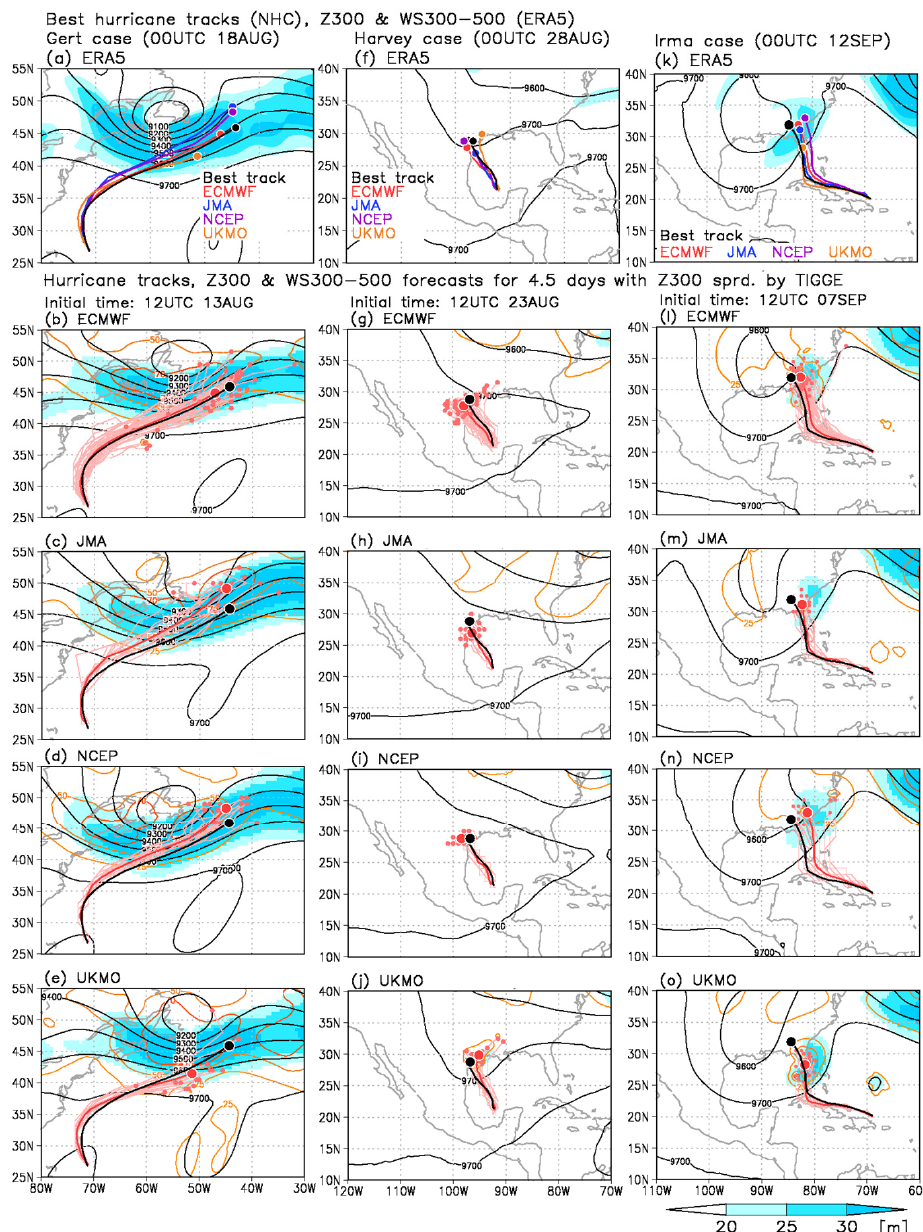
Figure 2. ( a ) Upper-level wind speed (averaged between 300- and 500-hPa levels; shaded; unit: m · s − 1 ) and geopotential height at 300 hPa (Z300; black contour; unit: m) at 0000 UTC 18 August 2017 from the fifth generation European Centre for Medium-Range Weather (ECMWF) atmospheric reanalysis of the global climate (ERA5); black line is track of Gert between 1200 UTC 13 August 2017 and 0000 UTC 18 August 2017 from National Hurricane Center (NHC) best track data; colored lines are ensemble means of tracks of Gert as predicted by the models of ECMWF (red), Japan Meteorological Agency (JMA; blue), US National Centers for Environmental Prediction (NCEP; purple) and UK Meteorological O ffi ce (UKMO; orange). ( b – e ) Predicted ensemble mean upper-level wind speed (averaged between 300- and 500-hPa levels; shaded; unit: m · s − 1 ), Z300 (black contour; unit: m), Z300 ensemble spread (orange contour; unit: m), predicted tracks of Gert between 1200 UTC 13 August 2017 and 0000 UTC 18 August 2017 with ensemble mean (thick line) and ensemble members (thin lines) from ( b ) ECMWF, ( c ) JMA, ( d ) NCEP, and ( e ) UKMO; black line is track of Gert from NHC best track data. Similarly, ( f – j ) and ( k – o ) are the same as ( a – e ) but for hurricanes Harvey and